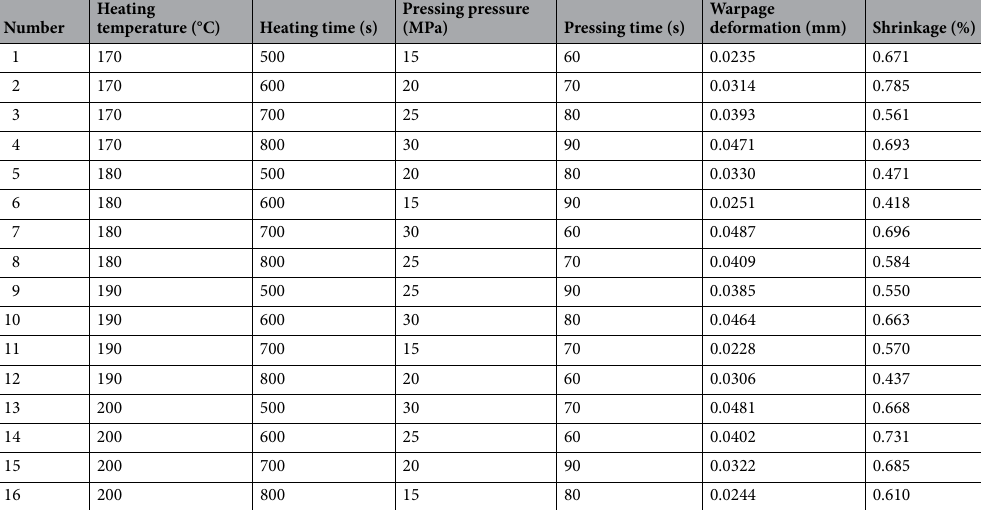
Table 6. Closed plastic impeller compression molding orthogonal test